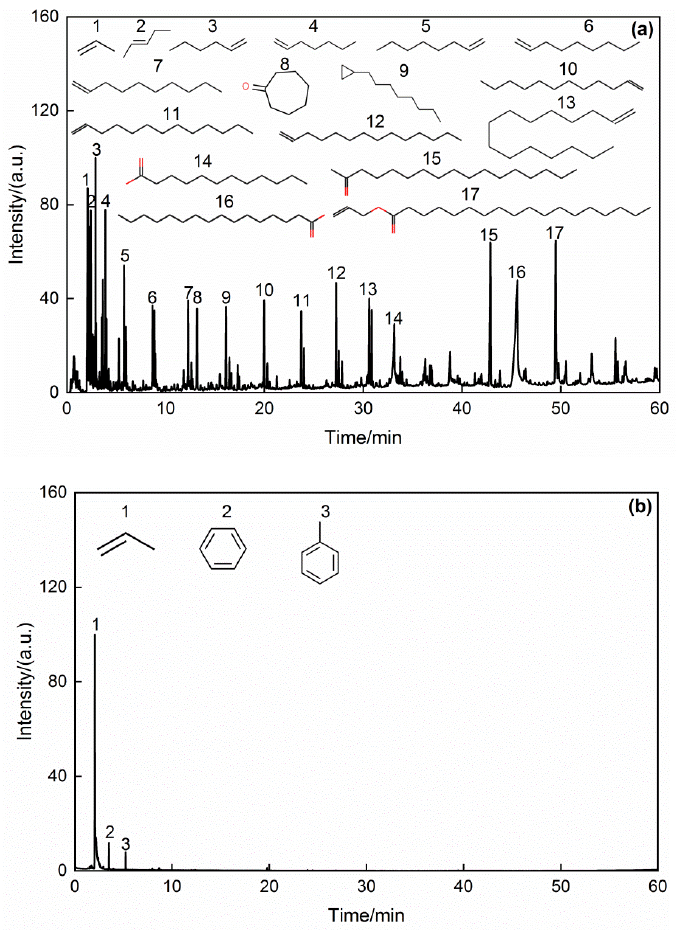
Figure 7. GC/MS chromatograms of volatile products from cold-rolling oil sludge pyrolysis at different temperatures: ( a ) 393–844 K; ( b ) 844–1173 K. Table 9. Classification of volatile products from cold-rolling oil sludge pyrolysis by GC/MS (area %).